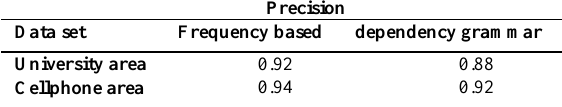
Table 9. Comparison D1 and university data set. Table 10. Comparison D4 and cellphone data set. Data